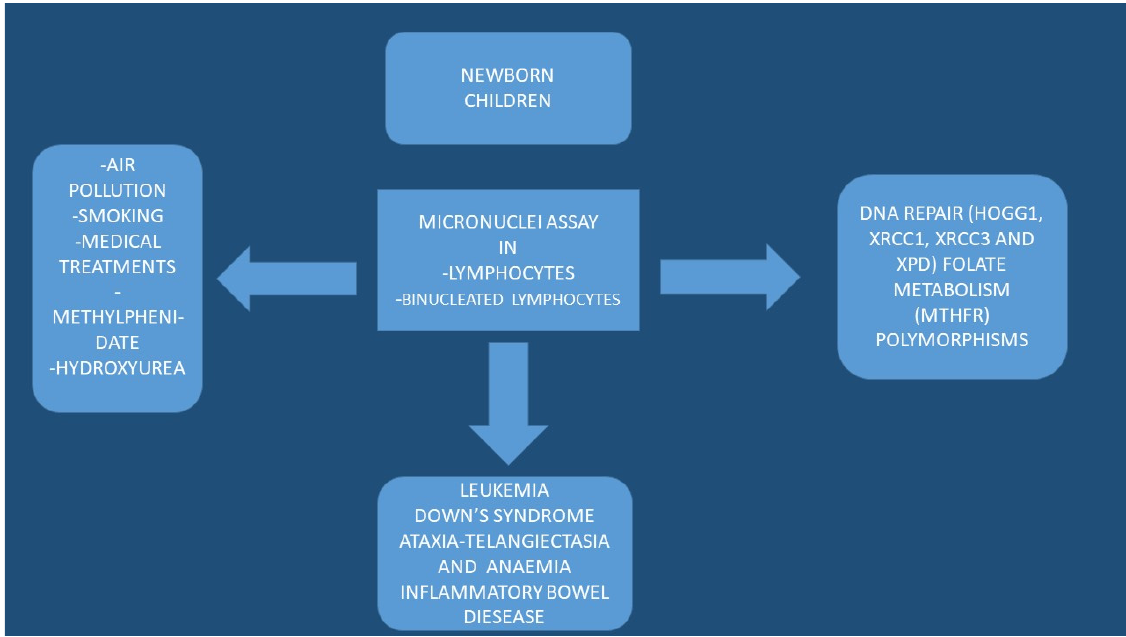
Figure 1. Graphical presentation of the factors affecting the nuclei and results.